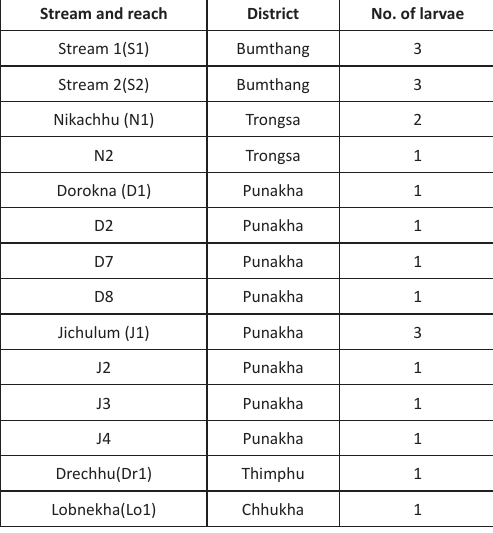
Table 1. Streams and reaches with district names and number of E. laidlawi larvae recorded. Stream and reach District No. of larvae Stream